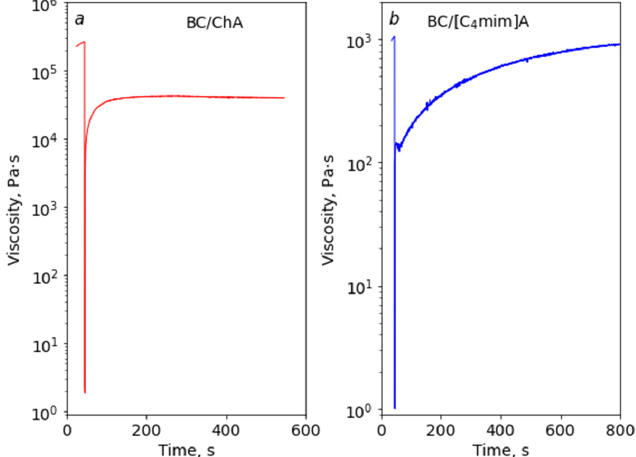
Figure 7. Thixotropy recovery tests for the BC/ChA ( a ) and BC/[C 4 mim]A ( b )